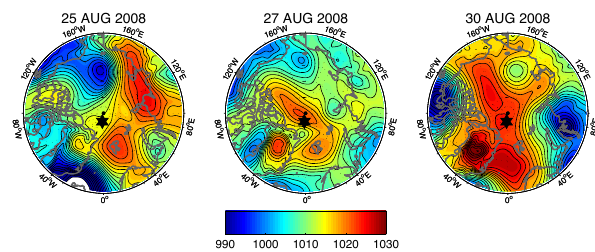
Fig. 2. ERA-Interim mean sea-level pressure (contours [hPa]) at Figure. 2. ERA-Interim mean sea-level pressure (contours [hPa]) at 12:00 UTC for 12:00UTC for three snapshots: 25 August (left), 27 August (mid- three snapshots: 25 August (left), 27 August (middle) and 30 August (right). The dle) and 30 August (right). The general location of ASCOS during general location of ASCOS during this week is shown as the filled black hexagram. this week is shown by the filled black